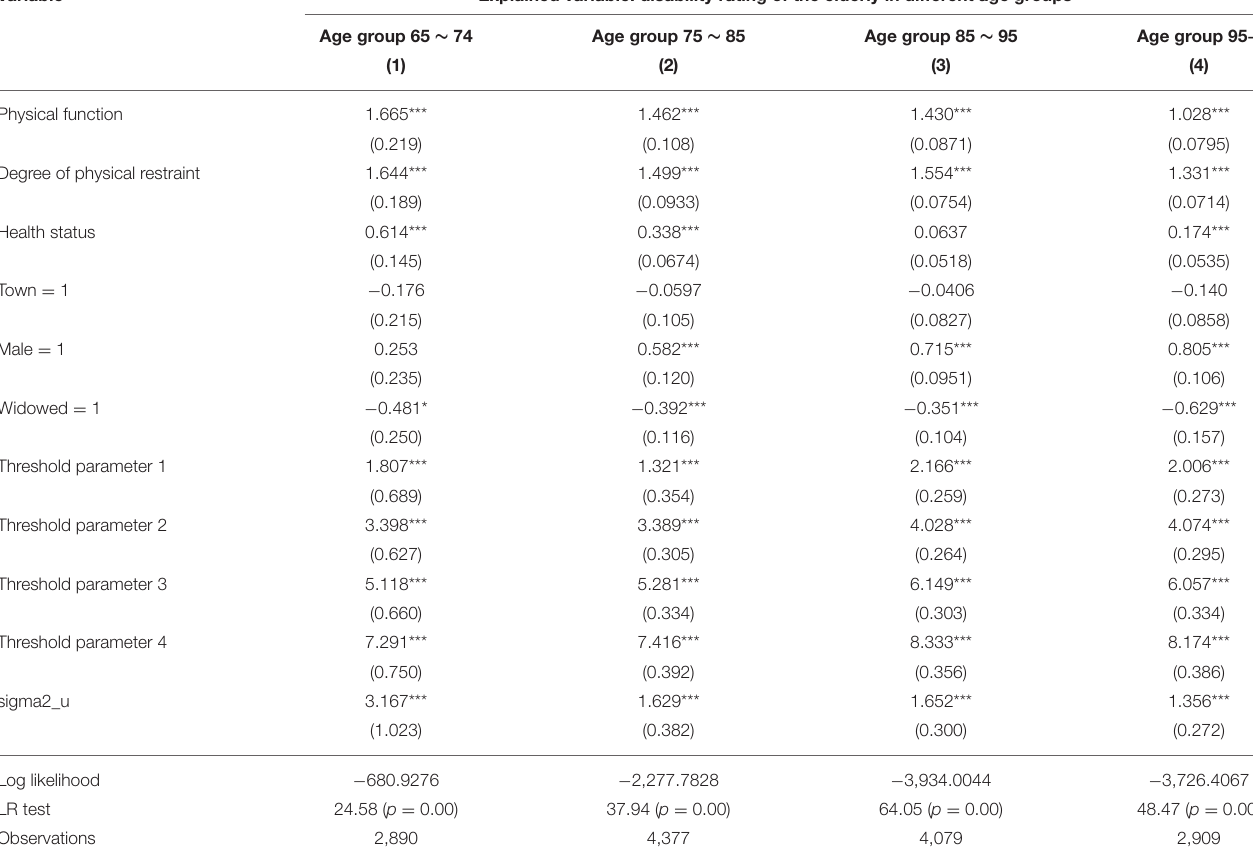
TABLE 3 | Logit disability state transition probability model.